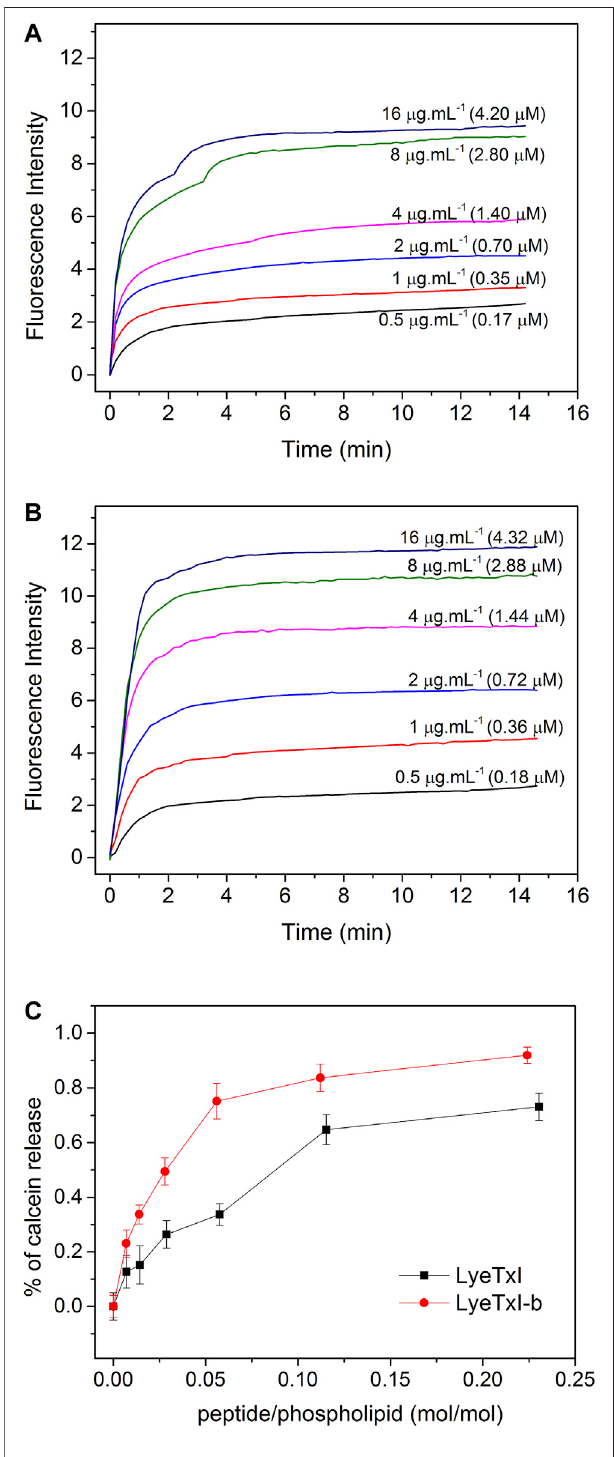
FIGURE 1 | Release of calcein encapsulated in 25 mM POPC:POPG LUVs(3:1,mol:mol),at25 ° C,inducedbydifferentconcentrationsof (A) LyeTxI and (B) LyeTxI-b. (C) Percentage of calcein released from LUVs in the presence of LyeTxI and